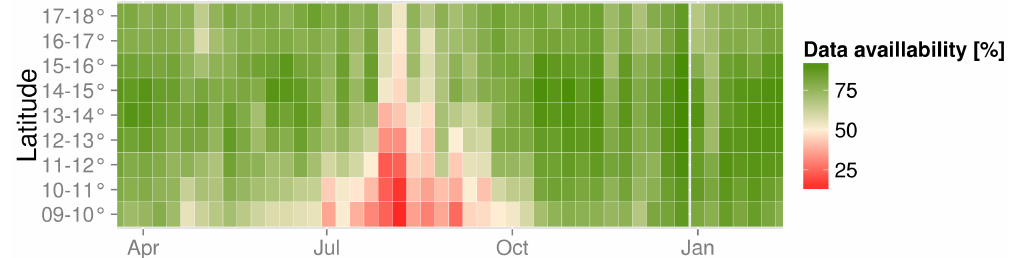
Figure 5. Percentage of data available for each degree of latitude ranging from 9°to 18°. Low data availability is observed in low latitudes and during vegetation growth (from July to